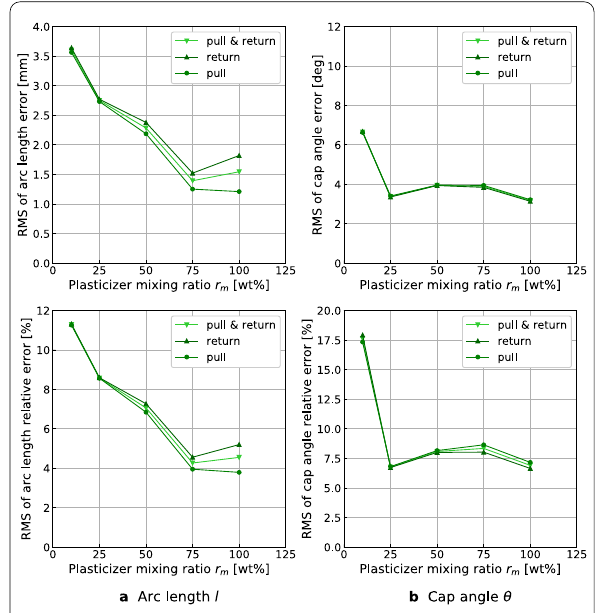
Fig. 16 Root mean square of error to plasticizer mixing ratio in deformation pattern